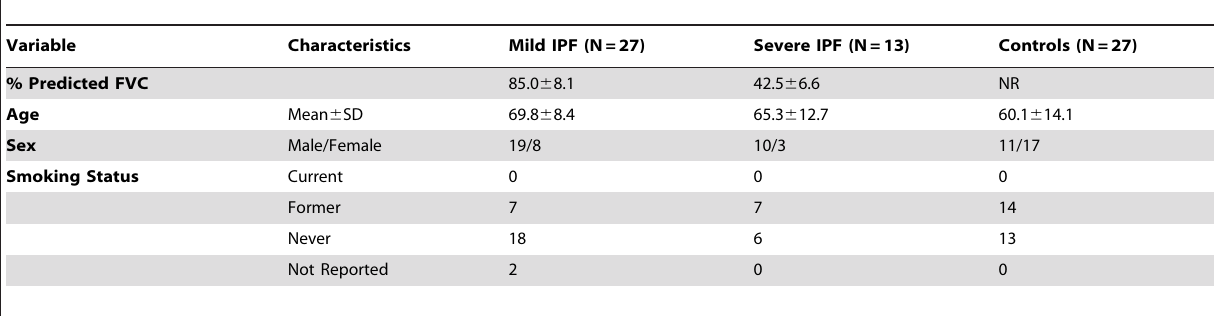
Table 1. Clinical and demographic IPF variables categorized by FVC.